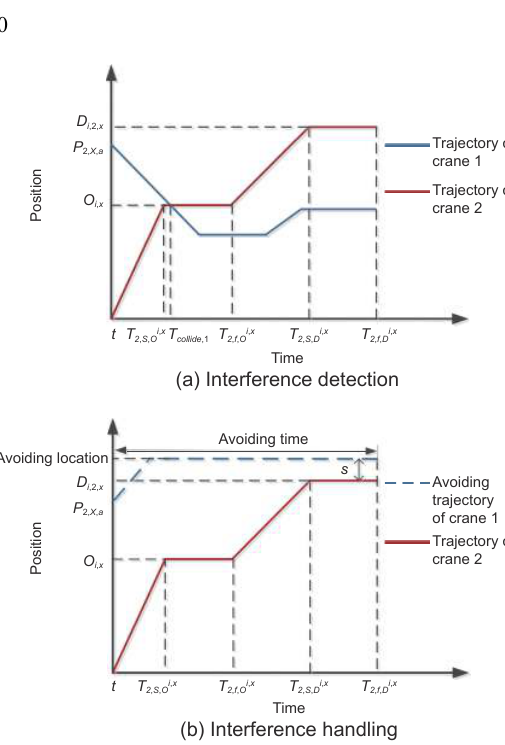
Fig. 8 Avoiding crane with avoidance travel.